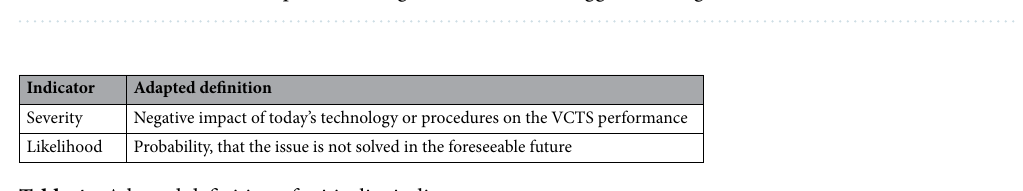
Table 3. Identified critical aspects with regard to VCTS and suggested mitigation measures.